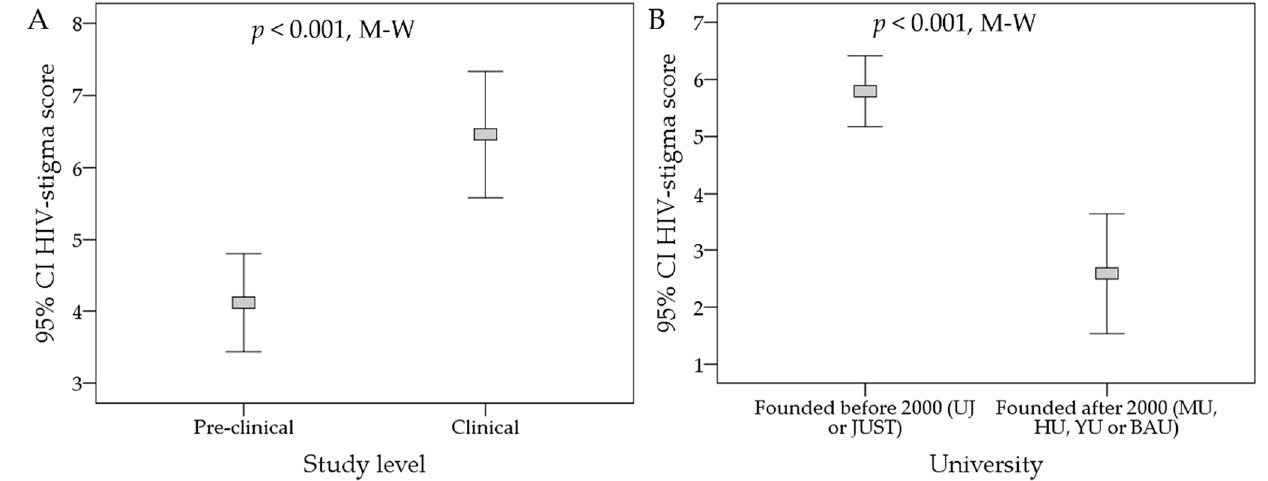
Figure 3. Factors that were correlated with significant differences in HIV-stigma score among the study participants. ( A ) Comparison was based on the study level of the participants (pre-clinical vs clinical students); ( B ) Comparison was based on the time the medical school was founded (before the year 2000 vs. following the year 2000). HIV: Human immunodeficiency virus, UJ: the University of Jordan; JUST: Jordan university of science and technology; MU: Mutah University; HU: the Hashemite University; YU: Yarmouk University; BAU: Al-Balqa Applied University; M-W: Mann-Whitney U test, 95% CI: 95% confidence interval of the mean; the grey rectangles in error bars represent the